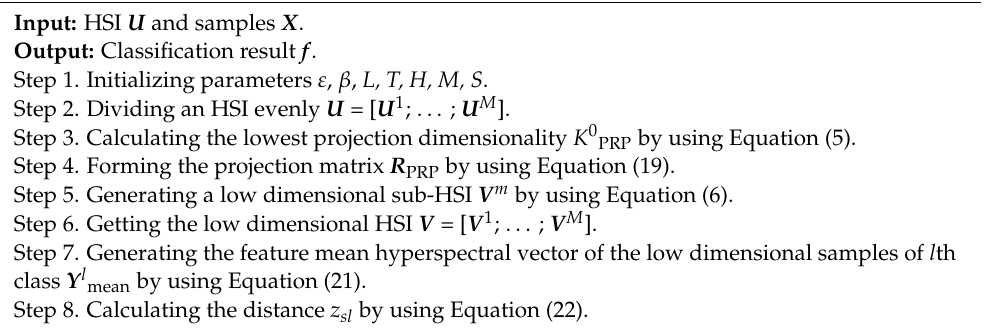
Algorithm 1 The detailed process of the proposed classification algorithm